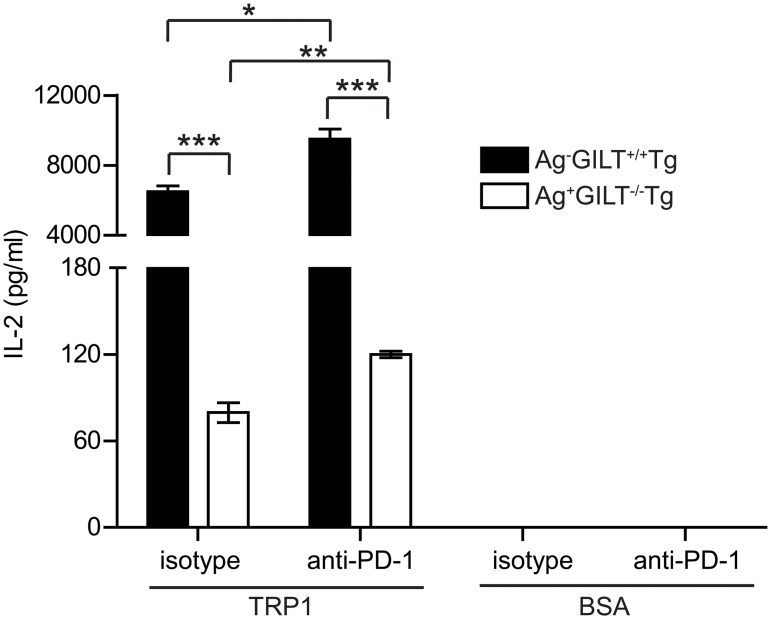
PD-1 suppresses IL-2 production by melanoma-specific T cells from TRP1-expressing mice.CD4+ lymph node cells from Ag-GILT+/+Tg and Ag+GILT-/-Tg mice were cocultured with T cell-depleted splenocytes from wild-type mice and TRP1 peptide or BSA (negative control) with either a PD-1 blocking monoclonal antibody or an isotype control antibody. IL-2 production was measured by ELISA. Columns and bars represent means ± standard error of triplicate samples from one experiment. Data are representative of two independent experiments and are compared by ANOVA with the Tukey correction for multiple comparisons (*p<0.05; **p<0.01; ***p<0.001).